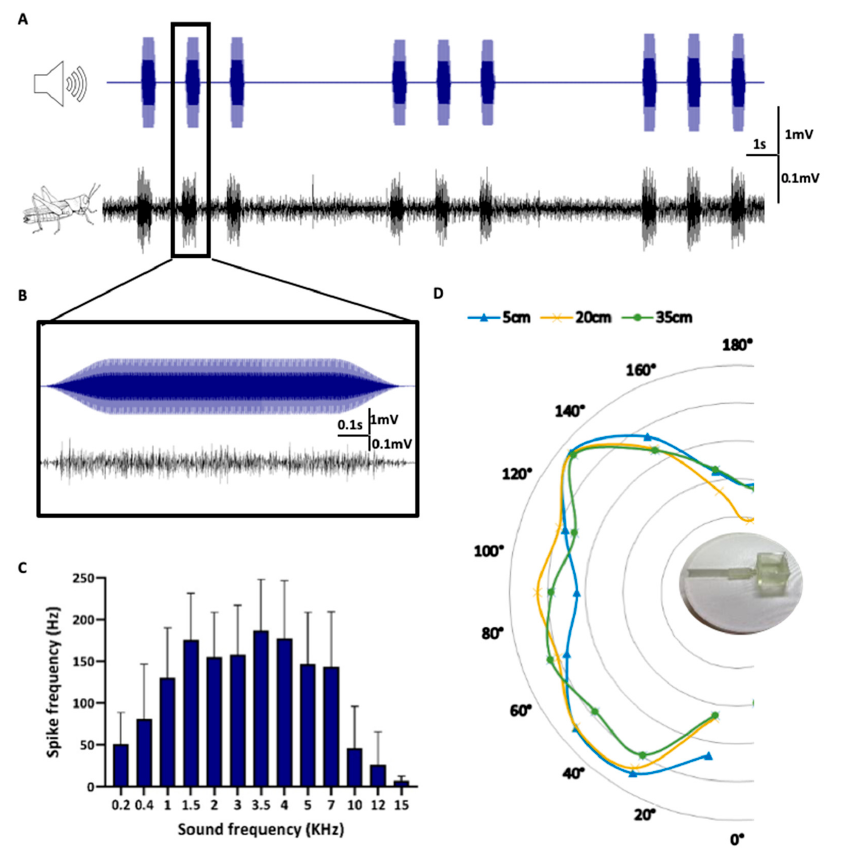
Figure 3. Characterization of the Ear-Chip response to sounds ( A ). Locust hearing organ’s electrophysiological responses (Black, Bottom) to sounds produced from a speaker (Blue, Top) ( B ). Zoom in to one of the pulses. ( C ) Spike frequency of the sensor response to different sound frequencies. 3.5 kHz seems to trigger the strongest response (n = 6), cross correlation analysis presented in Figure S5. ( D ) Spike frequency of the sensor response to sound in 3.5 kHz from different angles and distances. The sensor shows response to a range of angles for all distances tested with no significant difference (n = 6). Spike frequency of the sensor response represented by the distance of the line from the center of the circle.